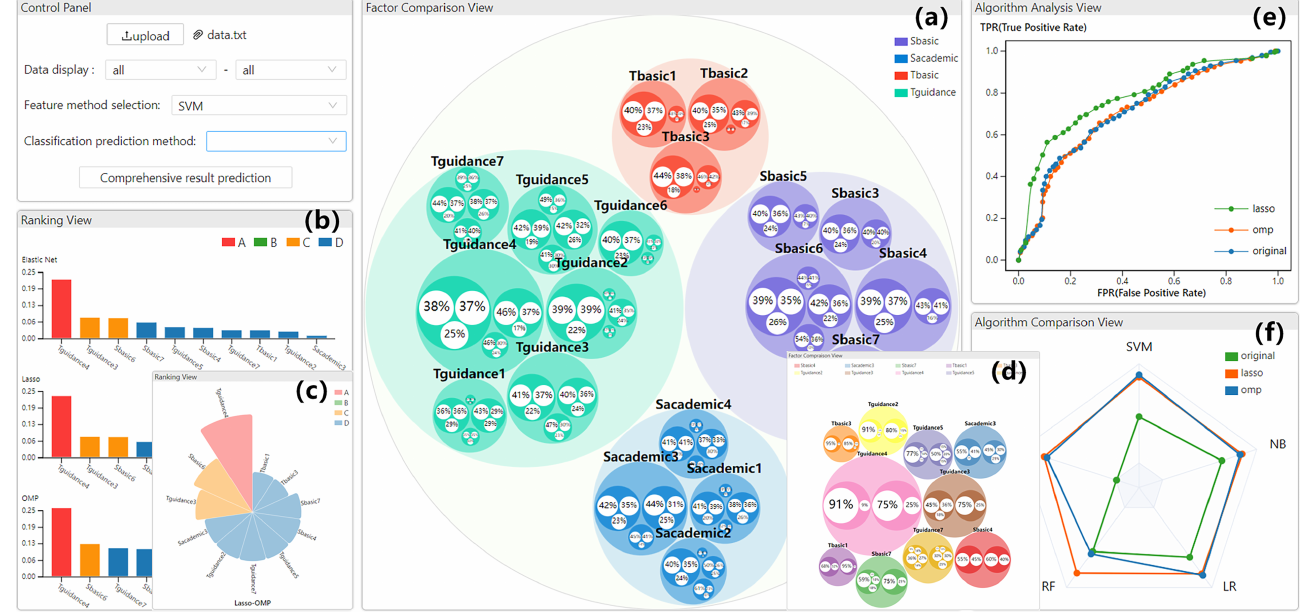
Figure 2. Visual analysis interface for graduate training exploration system. The Factor Comparison View details data of the graduate training process based on the questionnaire ( a ) and shows the predicted results of factors influencing the publication of first-grade graduate students ( d ). The Ranking View shows the comparison of the ranking of the results derived from the three factor selection methods ( b ) and the ranking results of the synthesis of the factor selection methods ( c ). The Algorithm Analysis View shows the ROC curves for the five classifications based on different factor selection methods ( e ). The Algorithm Comparison View compares the AUC values of the five classification methods based on different factor selection methods ( f